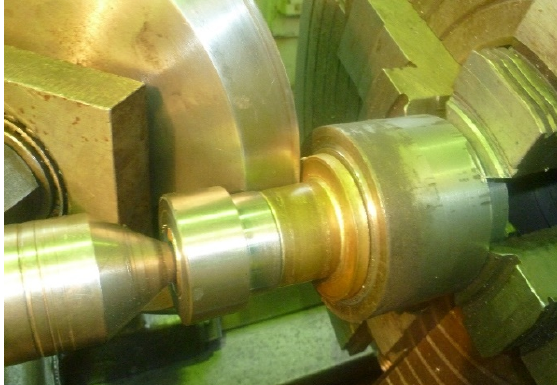
Figure 7. The working area of the experimental stand on the basis of lathe DIP 300 (1M63).